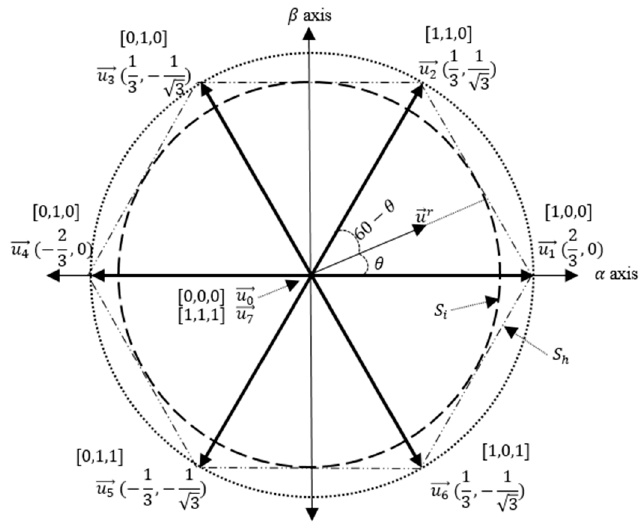
Figure 3. Voltage vectors and input constrained set.